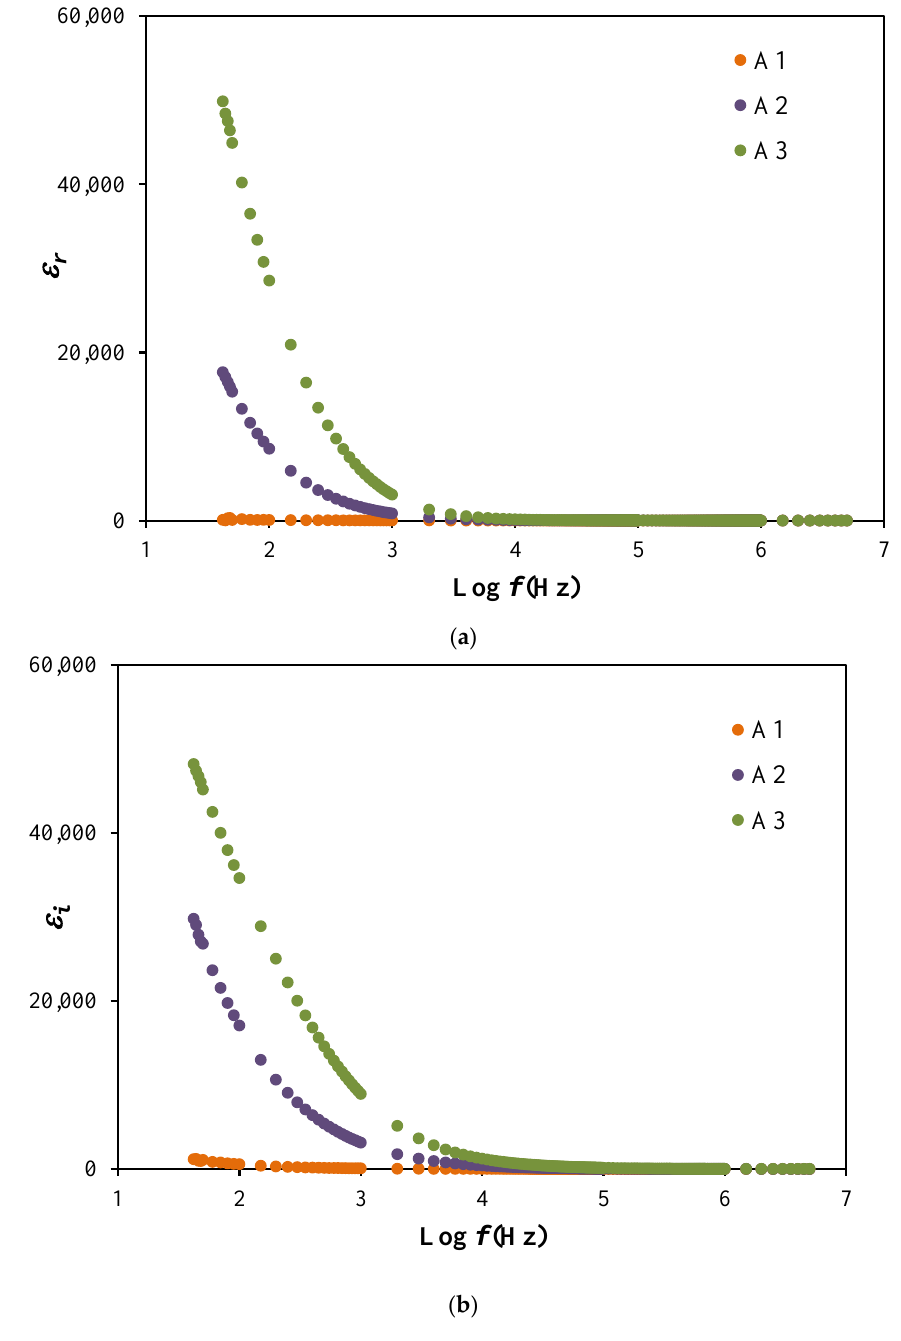
Figure 4. The plot of ( a ) 𝜀 𝑟 and ( b ) 𝜀 𝑖 for the electrolyte system.